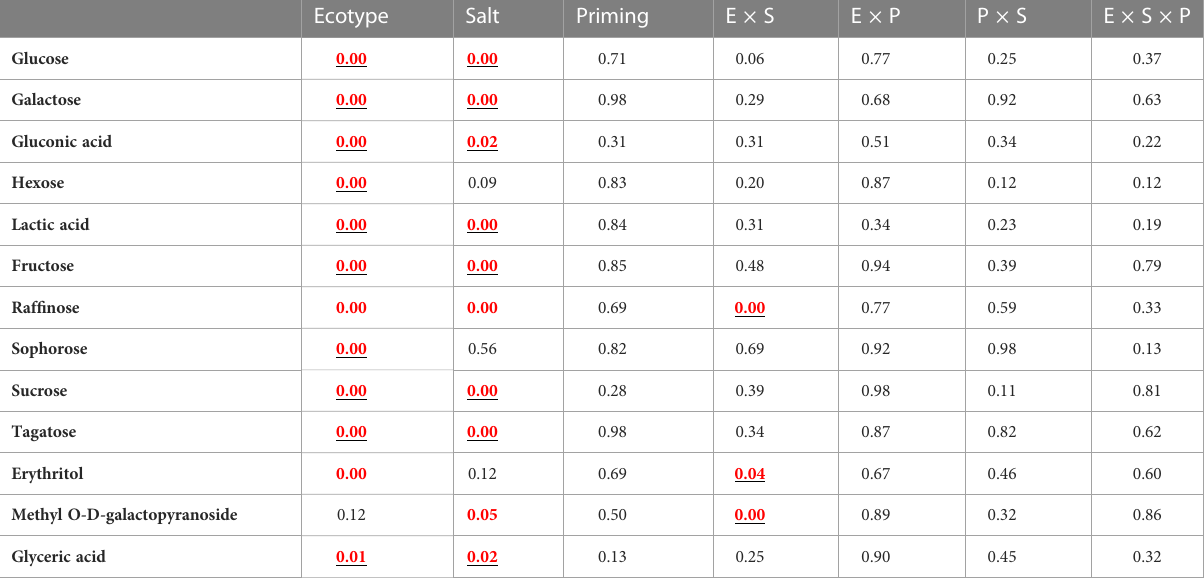
TABLE 1 P -values for the effects of Ecotype (E), Salt treatment (S), Priming (P), and their interactions, determined by three-way ANOVA analysis, on metabolites during the vegetative stage.